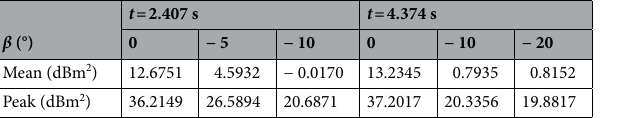
Table 8. RCS indicator of the aircraft in Z3 mode, α = 0° ~ 360°, f RH = 6 GHz, ω m1 = ω m2 = 0.1963 rad/s.